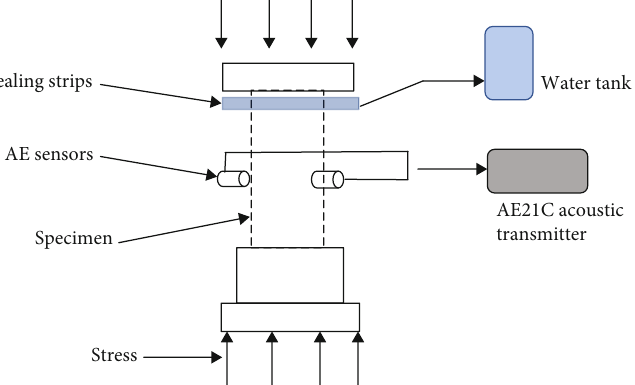
Figure 1: Schematic view of the testing system.